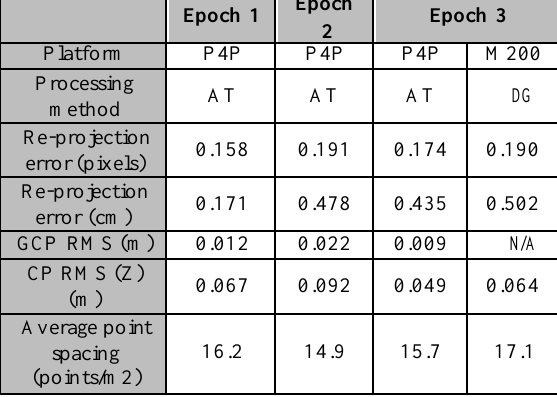
Table 3: Overview of image data processing.